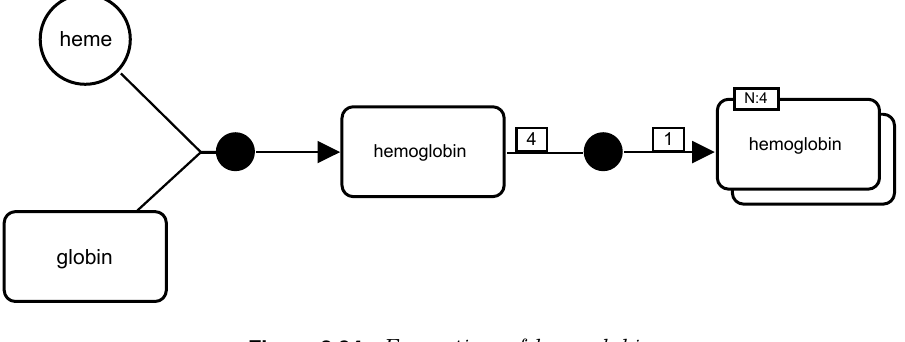
Figure 2.34: Formation of